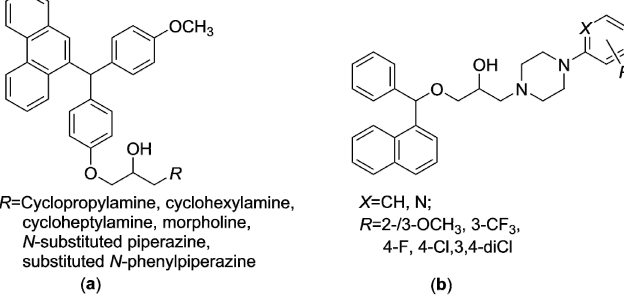
Figure 1. Highly lipophilic N -arylpiperazines, which contained: ( a ) a diaryloxymethanophenanthrene moiety; ( b ) a naphthalene moiety, have been promising compounds in vitro against M. tuberculosis H 37 R v strain.